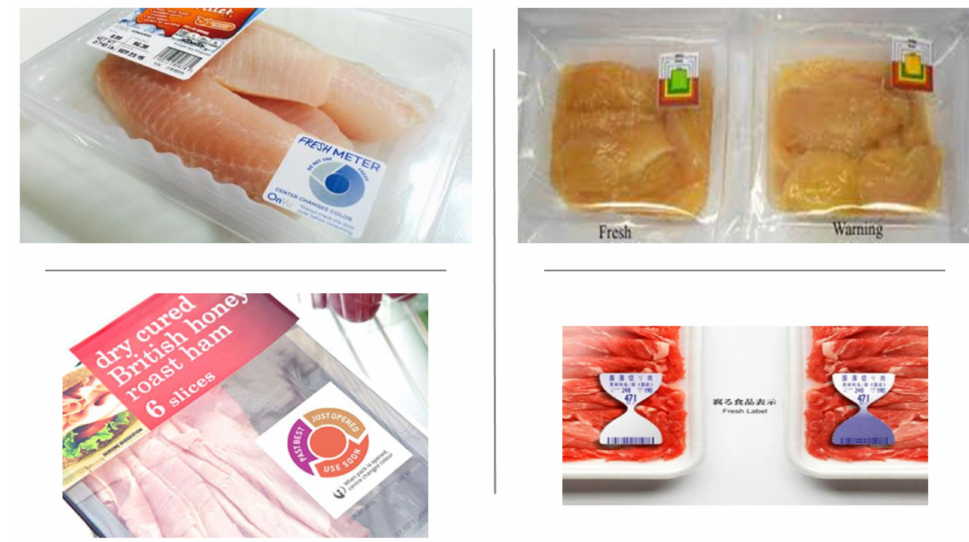
Figure 1. Various types of color indicators in food packaging